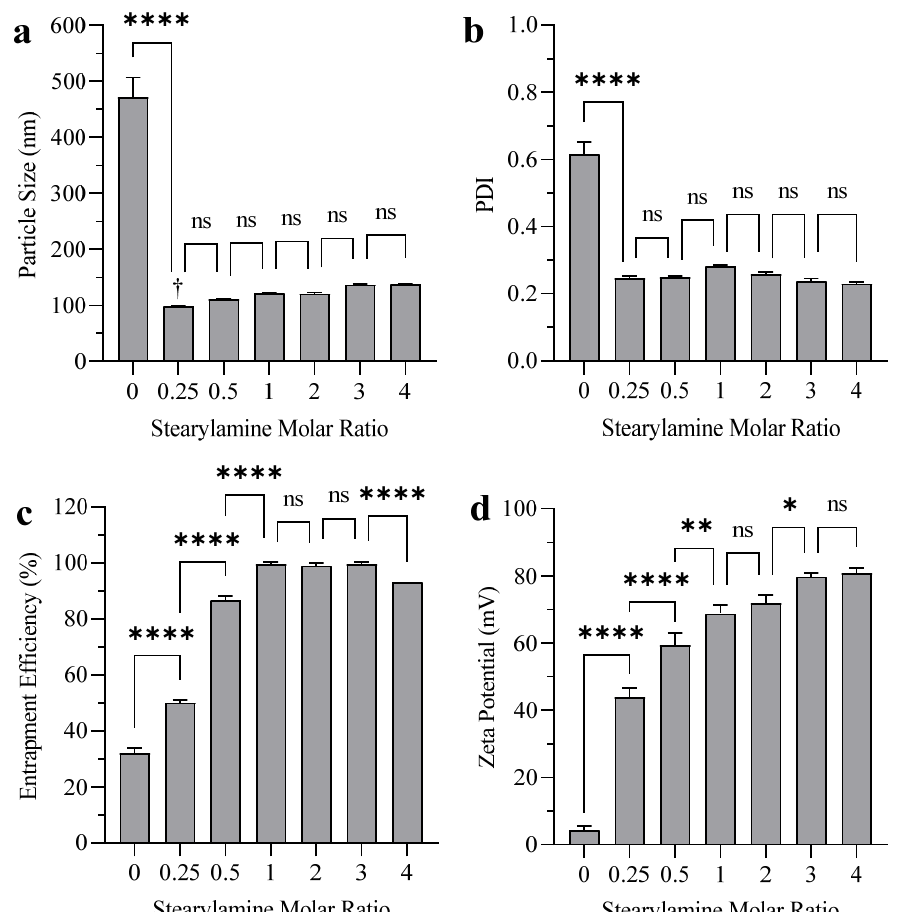
Figure 2. The effect of SA molar ratio on the ( a ) particle size ( b ) PDI ( c ) EE, and ( d ) zeta potential of budesonide liposomes with DPPC:CH:SA molar ratio of 7:3:X (where X represents various molar ratios of SA: 0, 0.25. 0.5, 1, 2, 3 and 4) without bile acid prepared by sonication. Notes: The data represent the mean ± standard deviation (n = 3). (ns p ≥ 0.05, * p < 0.05, ** p < 0.01, **** p < 0.0001) compared to adjacent formulation(s). †: Small degree of aggregation was detected visually and by DLS.